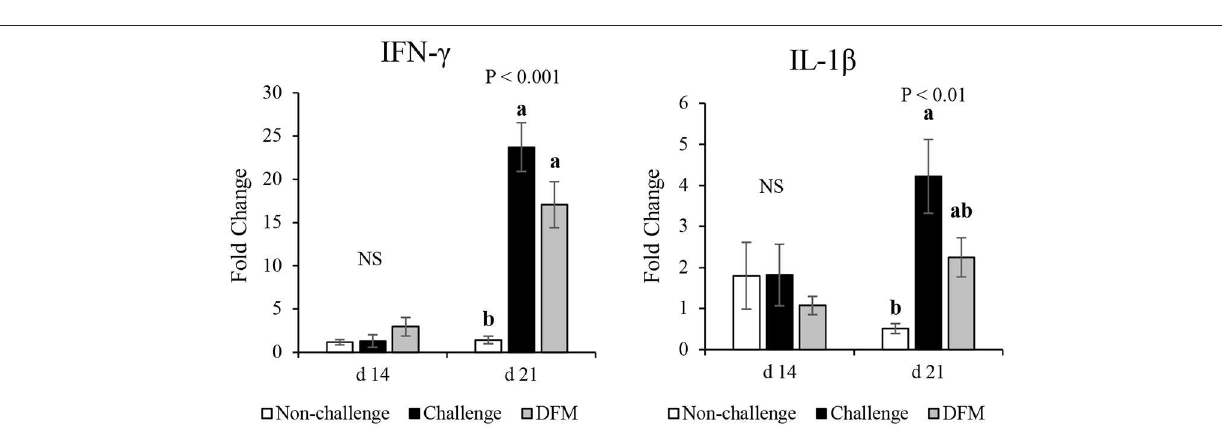
FIGURE 6 | Effect of dietary DFM supplementation on IFN- γ and IL-1 β mRNA expression in the ileum on d 21. Each bar represents the mean ± SE. a,b Bars with different superscripts are significantly different ( P < 0.05). NS, Not